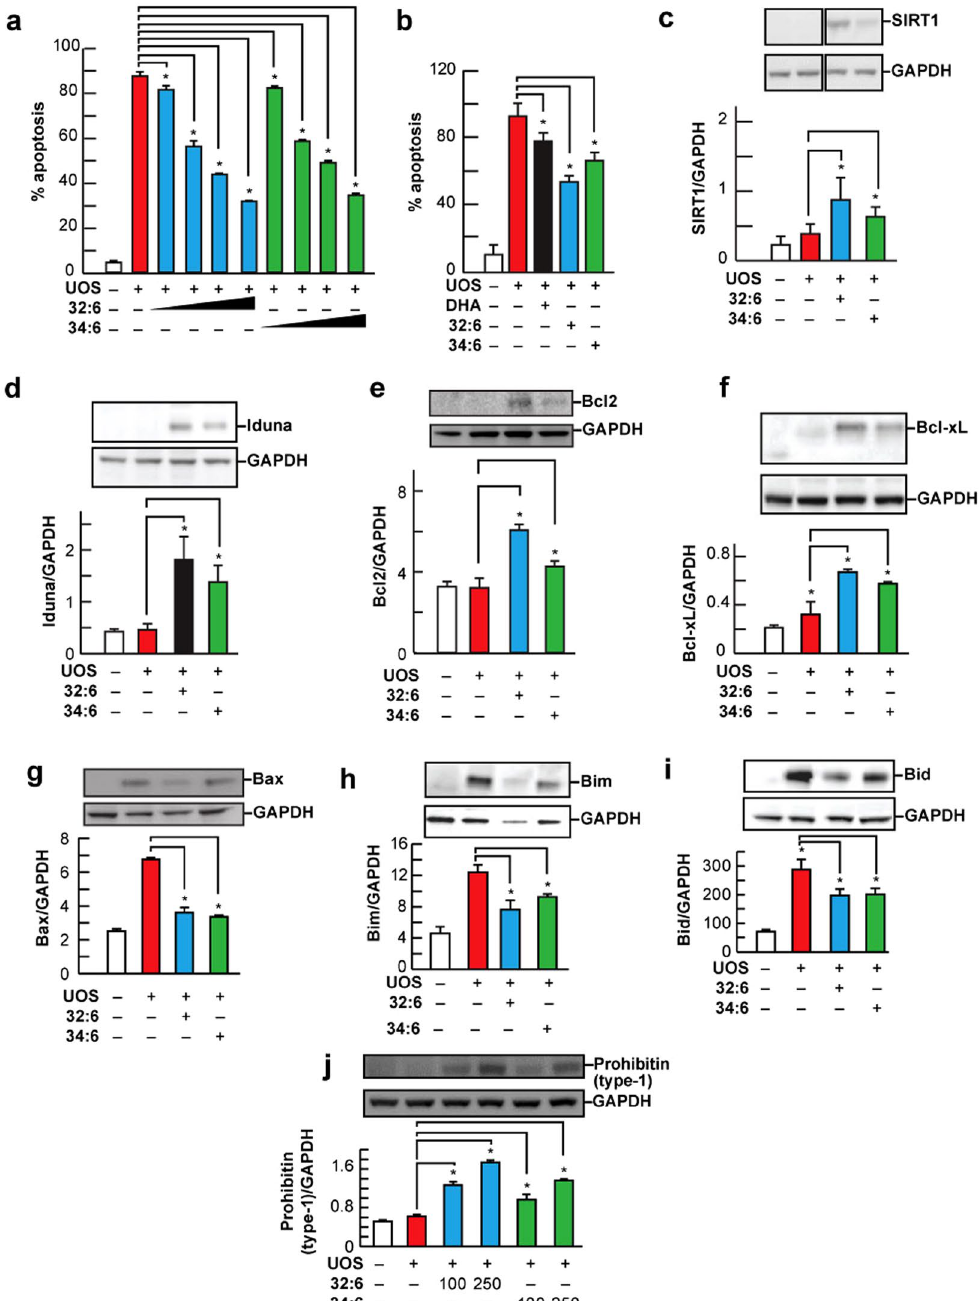
Figure 3. Cytoprotection by 32:6n3 and 34:6n3 in human RPE cells under UOS. ( a ) Concentration-dependent anti-apoptotic activity of 32:6n3 and 34:6n3 in human RPE cells (ARPE-19 cells). Confluent (80%) ARPE-19 cells in 12-well plates were serum starved for 8 hours, UOS was induced and then challenged with 50–500 nM 32:6n3 or 34:6n3 free fatty acids for 16 hours. Treated cells were harvested, and Hoechst-positive pyknotic cells detected as described in the Methods. Data are averages of the counts of 15 wells of Hoechst-positive pyknotic cells of three independent experiments. (b ) -100nM, DHA-mediated cytoprotection compared with that of 32:6n3 or 34:6n3 (250 nM each) after UOS exposure (16 hours) in serum-starved ARPE-19 cells, as described before. Apoptotic cell death was detected as described above. Results are averages of three independent experiments. (c) SIRT1 upregulation by 32:6n3 and 34:6n3 in RPE cells under UOS. The results are the averages of three independent experiments (all together, 9 wells for each experiment) unless otherwise indicated. (d) Iduna abundance was enhanced by 32:6n3 or 34:6n3 in RPE cells under UOS. (e – i ) Effect of 32:6n3 or 34:6n3 on pro- and anti-apoptotic proteins: ( e ) Bcl-2, ( f ) Bcl-xL, ( g ) Bax, ( h ) Bim, and ( i ) Bid in ARPE-19 cells under UOS. Western blot detection of the effect of 32:6n3 and 34:6n3 on the up- and down-regulation of the above proteins in ARPE-19 cells under UOS. ( j ) Concentration-dependent (100 and 250 nM) upregulation of prohibitin (type- 1) abundance induced by 32:6n3 and 34:6n3 in RPE cells under UOS. Also, see Supplementary Figs 1 and